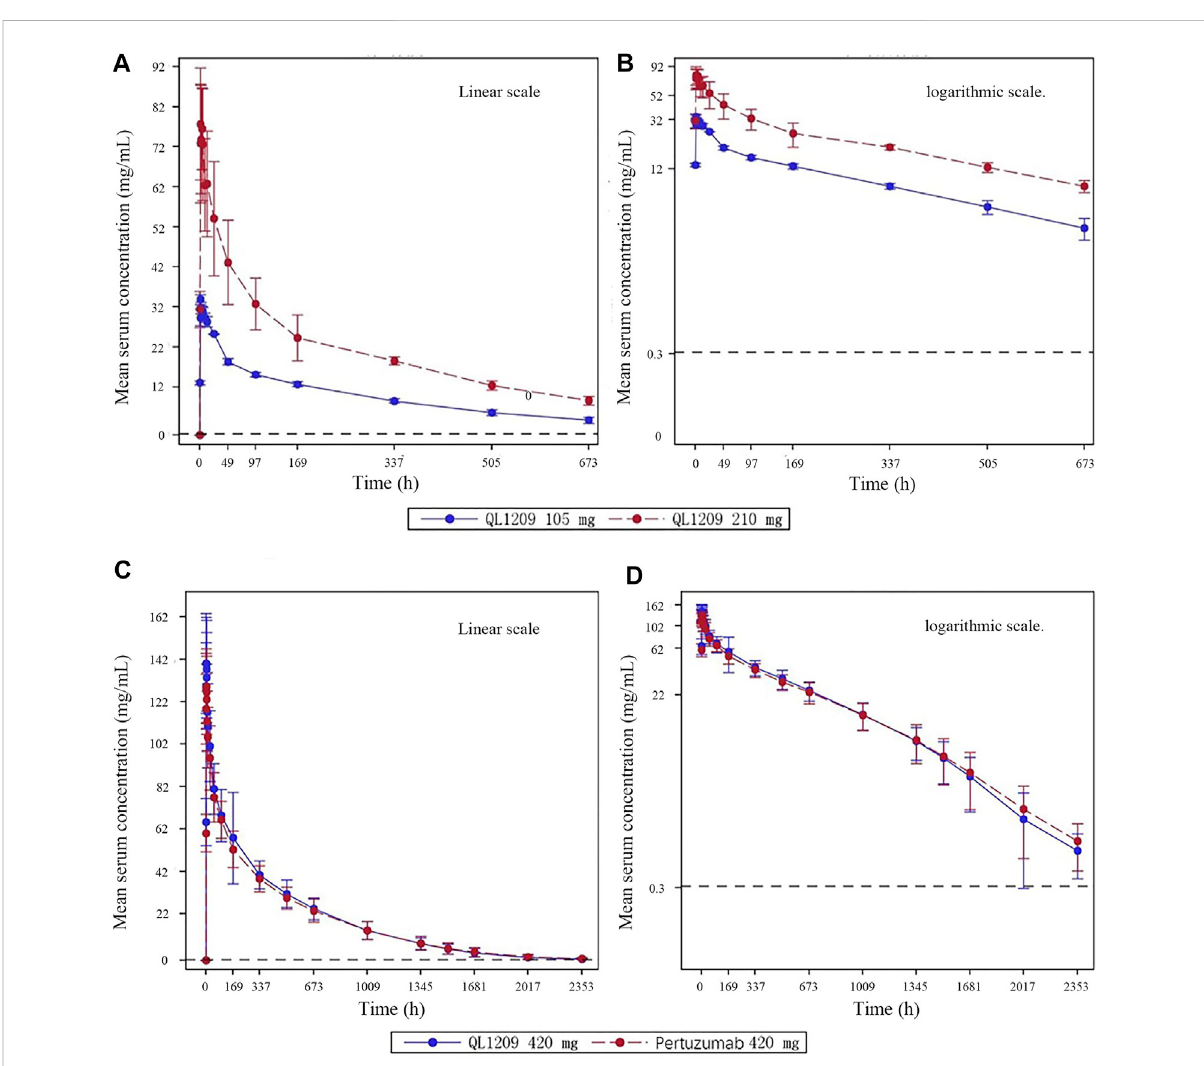
FIGURE 2 Meanbloodconcentrationtimecurve. (A) Meanplasmaconcentration(±SD)timecurveafterintravenousdripofQL1209105 mgor210 mg. (B) Logarthimic transformation of the mean plasma concentration (±SD) time curve after intravenous dripping of QL1209 105 mg or 210 mg. (C) Mean plasma concentration (±SD) time curve after intravenous dripping of QL1209 420 mg or Perjeta ® 420 mg. (D) Logarthimic transformation of the mean plasma concentration (±SD) time curve after intravenous dripping of QL1209 420 mg or 420